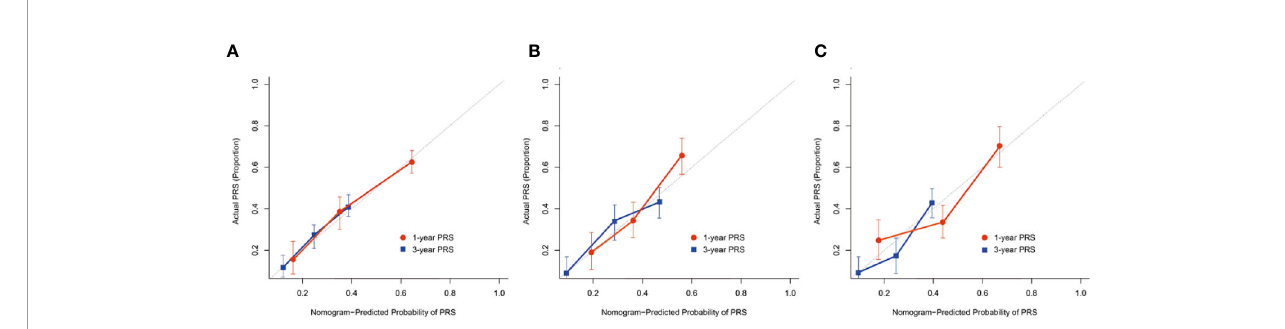
FIGURE 4 | The calibration curves demonstrating how the 1- and 3-year post-recurrence survival predictions from the model compare to the actual observed survival in the (A) training, (B) internal, (C) external validation cohort.